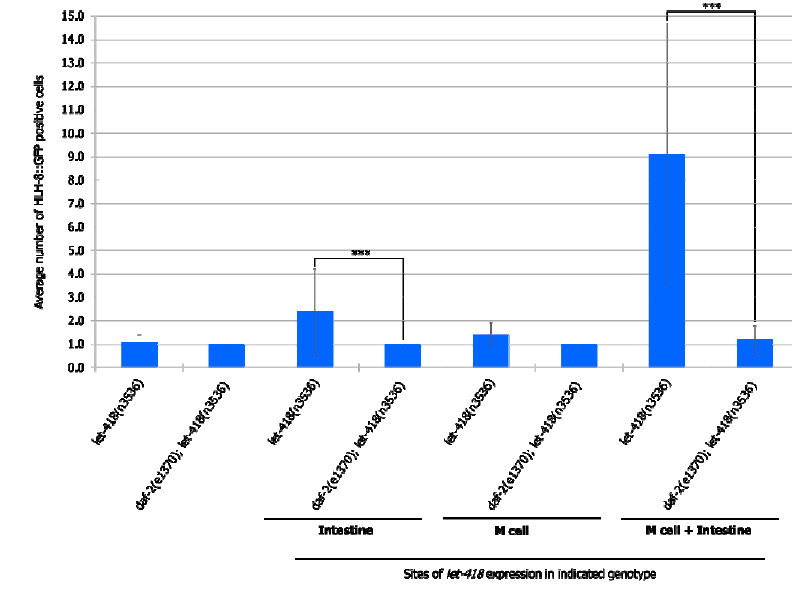
Figure 7. Insulin signaling is required for the cell non-autonomous effect of LET-418/Mi-2 on M cell division. ( A ) The percentage of worms with at least three M derived cells after 30 h after birth. Error bars indicate standard deviation. *** p < 0.001; Fisher’s test. ( B ) The average number of undifferentiated M lineage cells. Animals with intestinal LET-418 activity, including those with combined LET-418/Mi-2 activity in the intestine and M cell showed the average maximum of phlh-8::gfp positive cells after 30 h after birth. For clarity purpose the average number of M-cell descendants in wild type worms (18.7 ± 0.9) and in daf-2(e1370) mutants (17.1 ± 1.2) is not displayed on this graph. Error bars indicate standard deviation. *** p < 0.001; unpaired t -test.